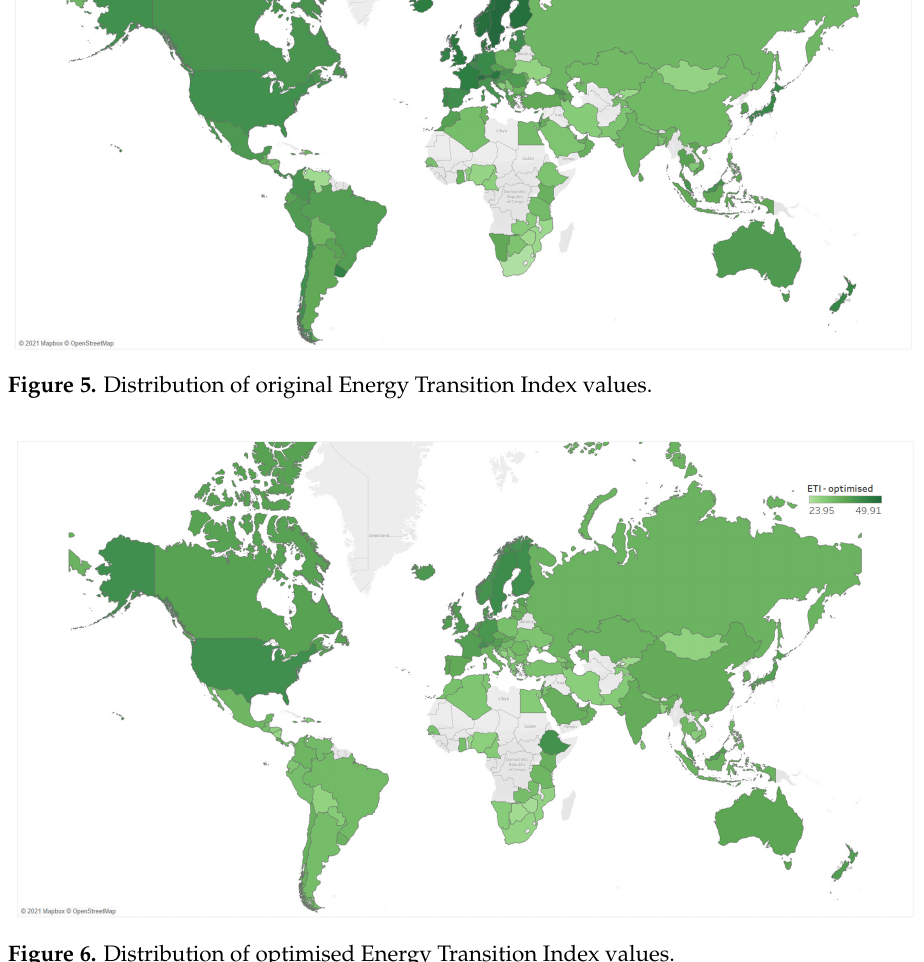
Figure 6. Distribution of optimised Energy Transition Index values. Table 3. Top and bottom five countries according to original and optimised ETI. Top Countries Bottom Countries Original ETI Optimised ETI Original ETI Optimised